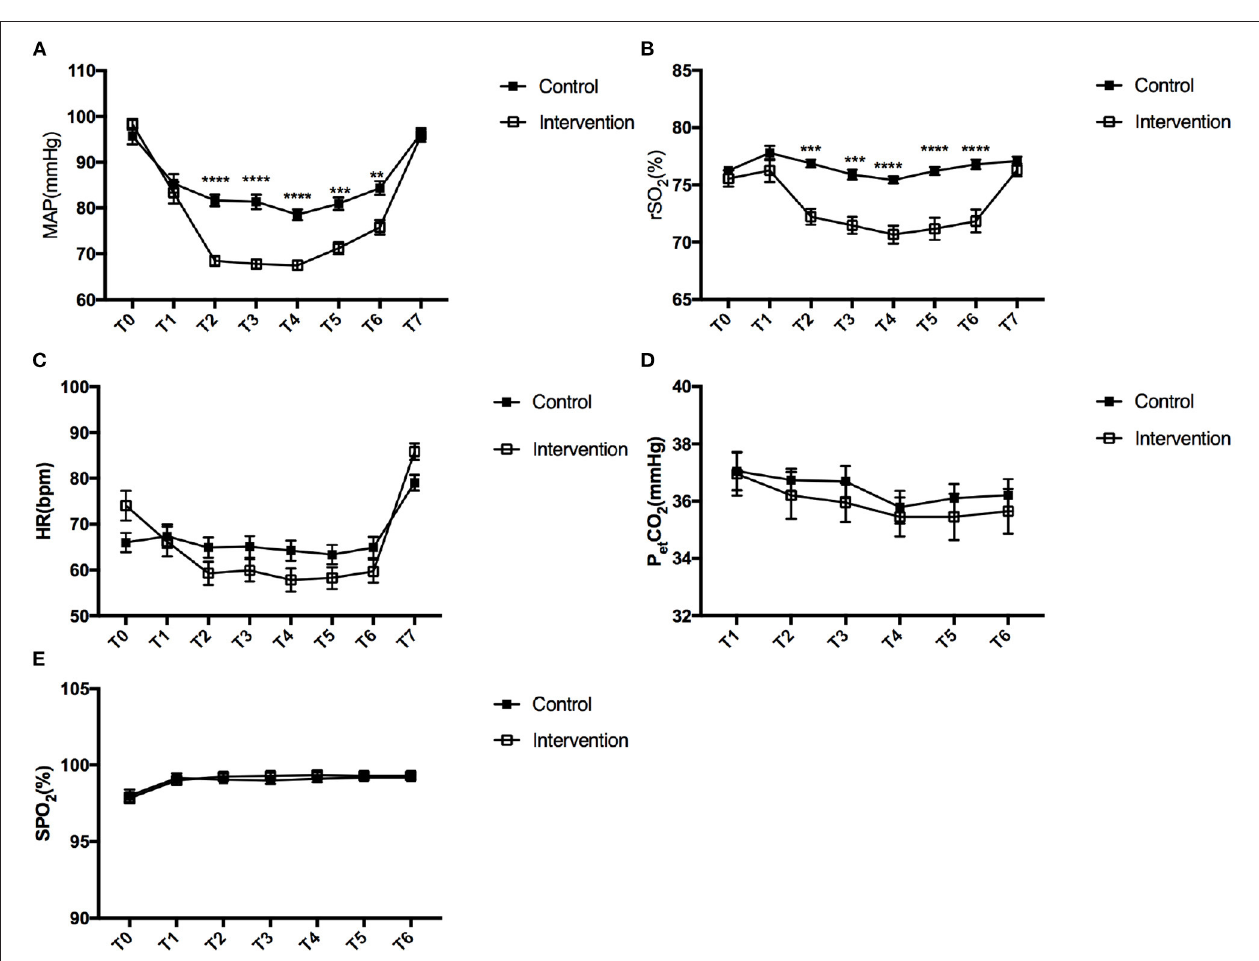
FIGURE 2 | Change in MAP (A) , rSO 2 (B) , HR (C) , PetCO 2 (D) , and SpO 2 (E) between the control and intervention groups during functional endoscopic sinus surgery. A square with error bars represents the mean and standard error of mean. T0 (baseline), before induction of anesthesia; T1, immediately after induction of anesthesia; T2, at the beginning of the operation; T3, 10min after the operation began; T4, 20min after the operation began; T5, at the end of the operation; T6, 5min after the end of the operation; T5, 15min after the end of the operation. MAP, mean arterial pressure; rSO 2 , regional cerebral oxygen saturation; HR, heart rate; SpO 2 , peripheral oxygen saturation; PetCO 2 , partial pressure of end-tidal carbon dioxide. ** P < 0.01, *** P < 0.001, **** P < 0.0001 vs. control